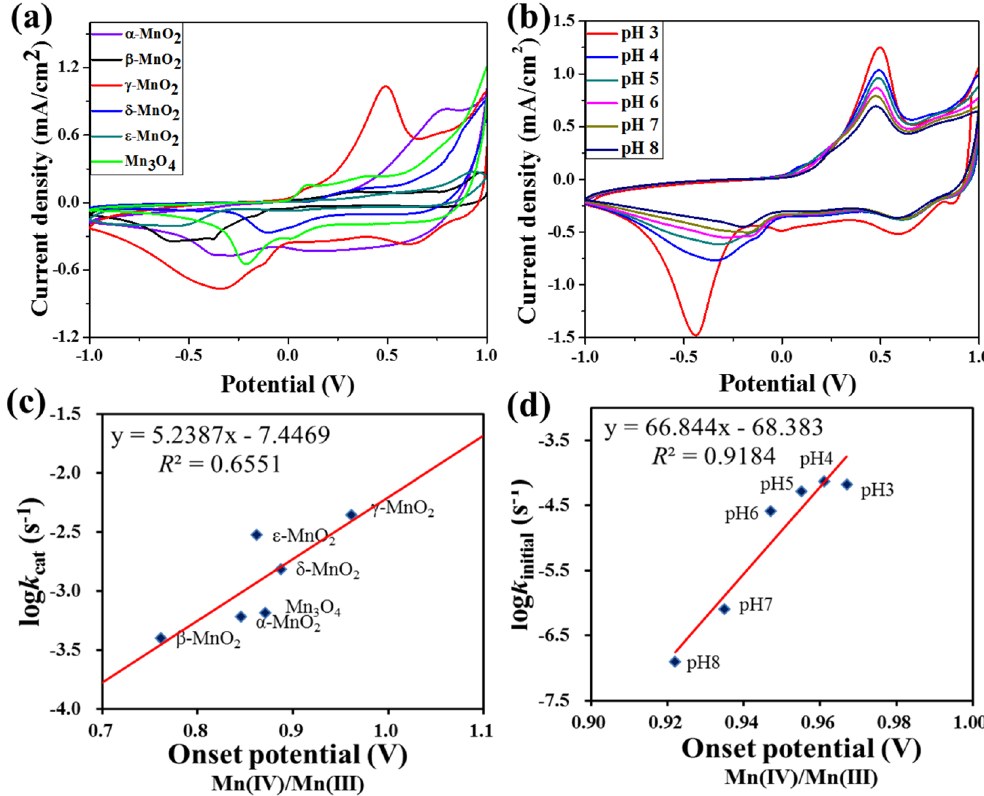
Figure 5. Cyclic voltammetry (CV) at the rate of 20 mV/s in acetate buffer containing 1.0 M KCl and no O 2 for ( a ) different MnO x at pH 6.0, and ( b ) γ -MnO 2 at different pH levels. The correlation between the reaction rate constants of the initial ABTS reactions and the onset potential of Mn(IV)/Mn(III) for ( c ) different MnO x at pH 6.0, and ( d ) γ -MnO 2 at different pH levels.